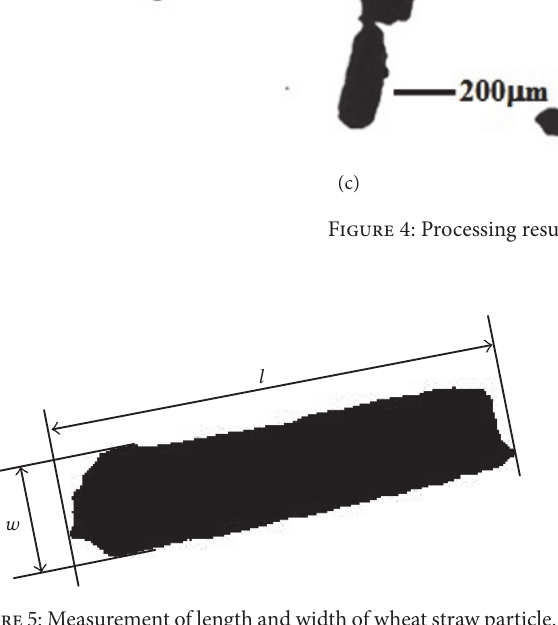
Figure 5: Measurement of length and width of wheat straw